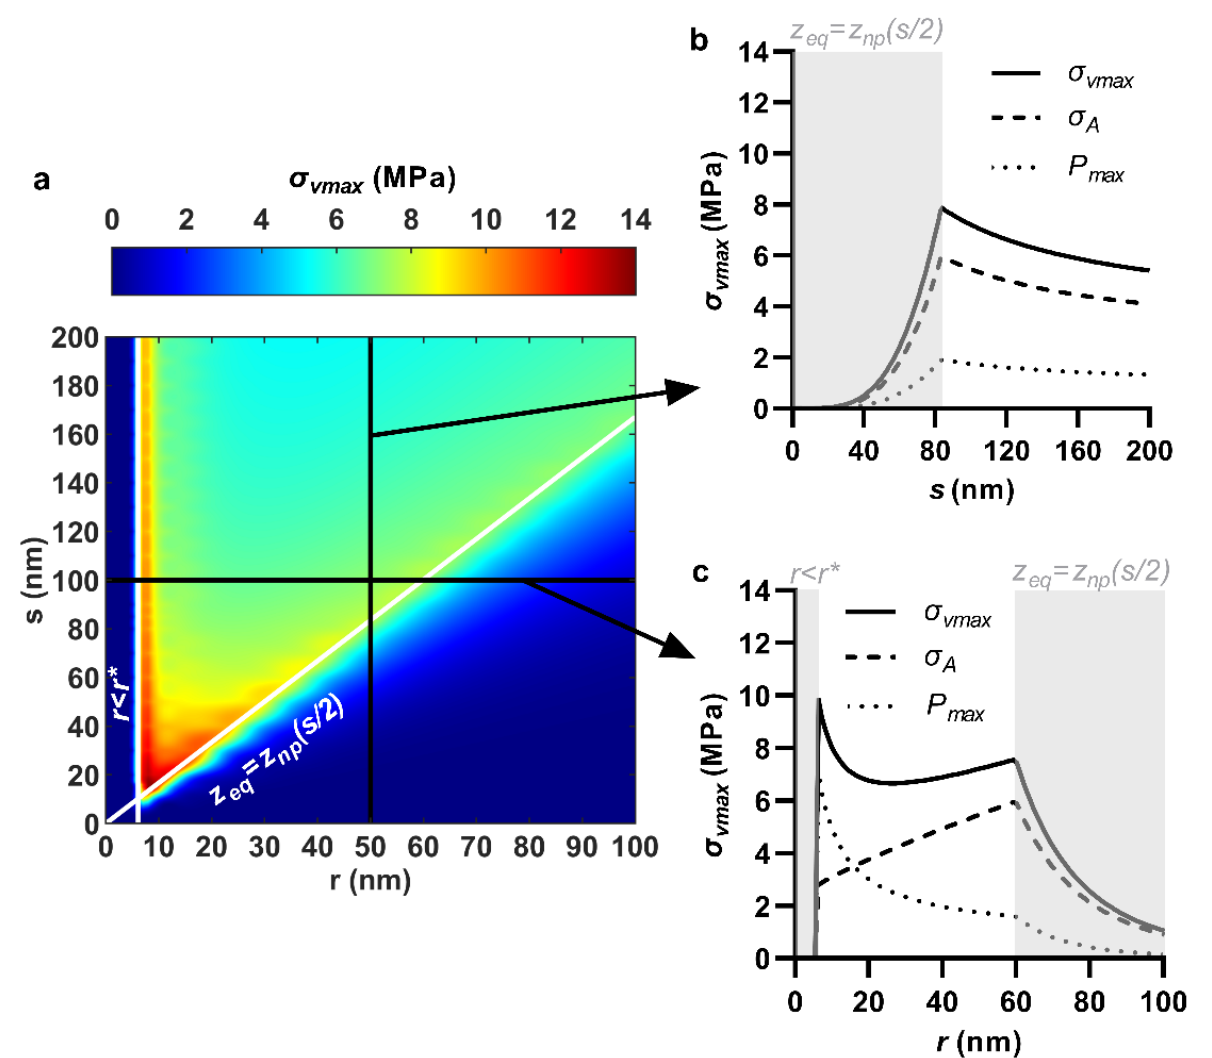
Figure 5. Effect of nanopillar quasi-tip radius, r , and center spacing, s , on maximum von Mises stress, σ vmax . ( a ) Combined effects of quasi-tip radius and center spacing shown as a contour plot; ( b ) Selective effect of center spacing, at a fixed quasi-tip radius of 50 nm; ( c ) Selective effect of quasi-tip radius, at a fixed center spacing of 100 nm. r < r* and z eq = z np ( s /2) indicate discontinuities due to emergence of a bending energy barrier and closing of interspace, respectively. For all cases, nanopillar height, pattern ordering, and work of adhesion were 200 nm, hexagonal and 20 mJ/m 2 , respec- tively.